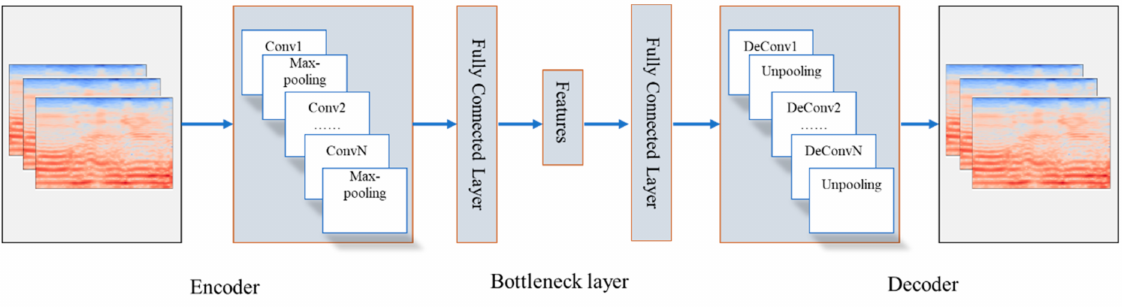
Figure 3. General framework of the autoencoder network, which consists of encoder and decoder